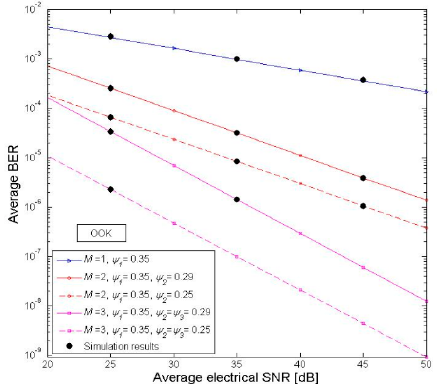
Figure 2. ABER versus electrical SNR for SISO and SIMO TOW system configurations with OOK and various NZB pointing errors conditions.